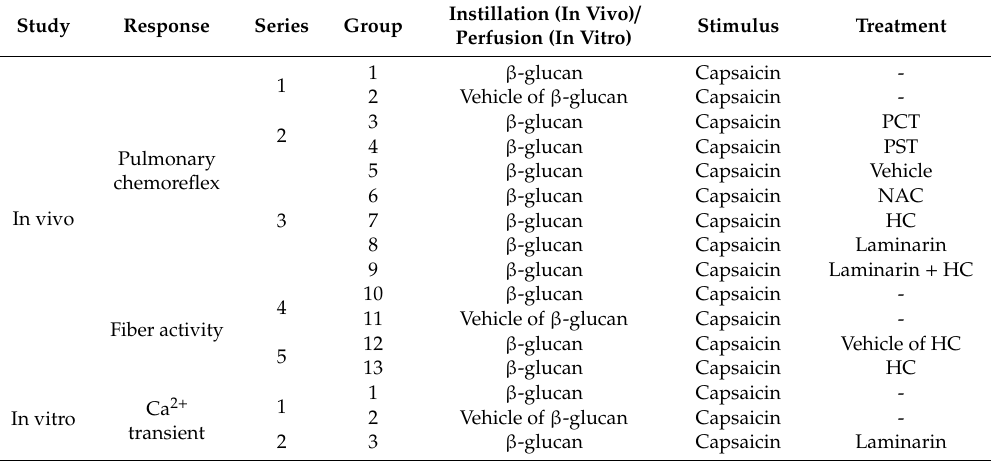
Table 1. Summary of the various experimental interventions in the study groups.